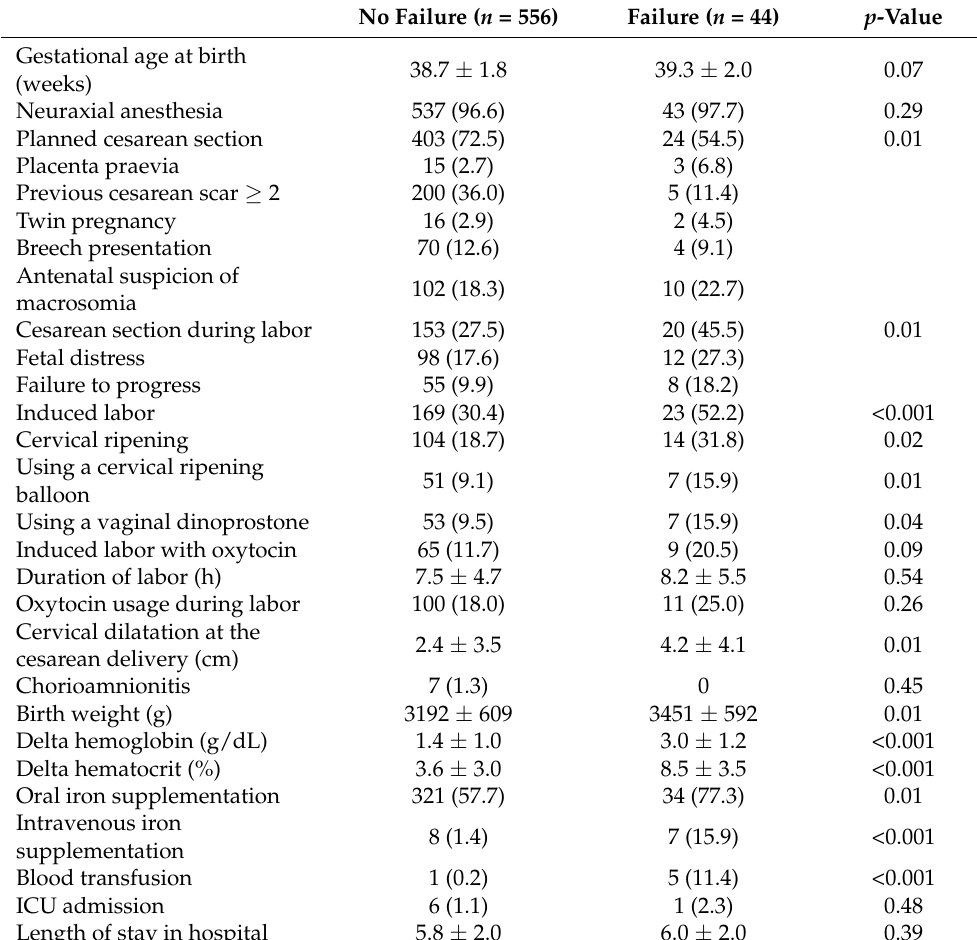
Table 2. Labor characteristics and maternal and neonatal outcomes according to the carbetocin efficacy.